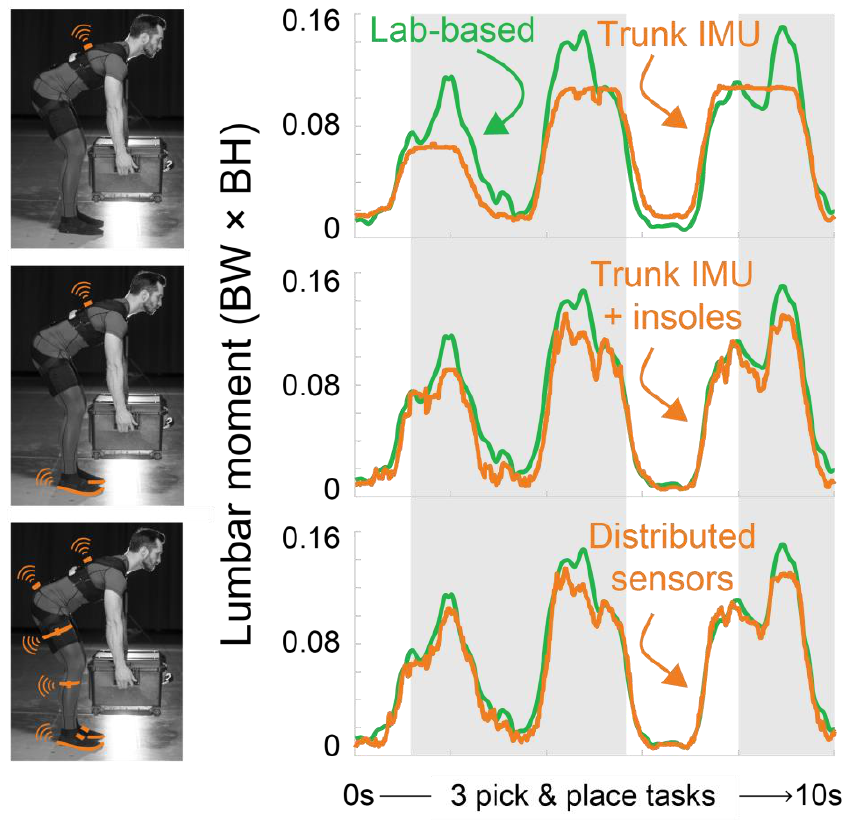
Figure 8. Single IMU wearable does not capture key trends and peaks in lumbar loading when objects are lifted. Time-series lab-based lumbar extension moment (green) and idealized wearable algorithm moments developed with three different idealized wearable sensor combinations (orange). Shown is an example lifting task from the hundreds of manual material handling tasks performed for an example participant; 3 pick and place task cycles with a 10 kg box shown. While we only show a subset of time-series results here, we observed similar algorithm accuracy trends across the broad range of manual material handling tasks collected. Gray areas are approximately when the participant was holding the 10 kg box, white areas are when the participant had no object in their hands. The trunk IMU tends to perform worse when the box is being held or lifted, whereas the trunk IMU plus pressure insoles, and distributed sensors, are able to better track key lumbar loading trends (gray areas). BW × BH = body weight × body height.